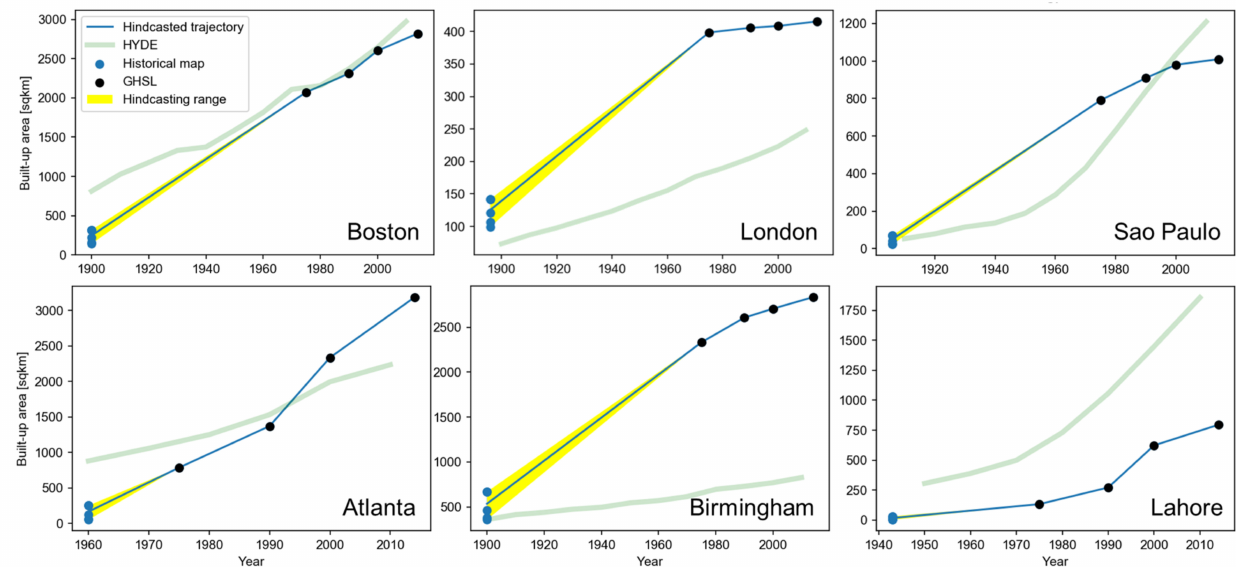
Figure 11. Hind-casted GHSL urban growth trajectories (extracted historical urban areas are GHSL-constraint, k = 4, averaged across any post-processing scenario) and their deviation, overlaid with HYDE 3.2 urban area trajectories. These trajectories are composed of four remote-sensing-based observations (from the GHSL) and an earlier observation obtained from the historical maps, allowing for hind-casting the GHSL-based trajectories to earlier points in